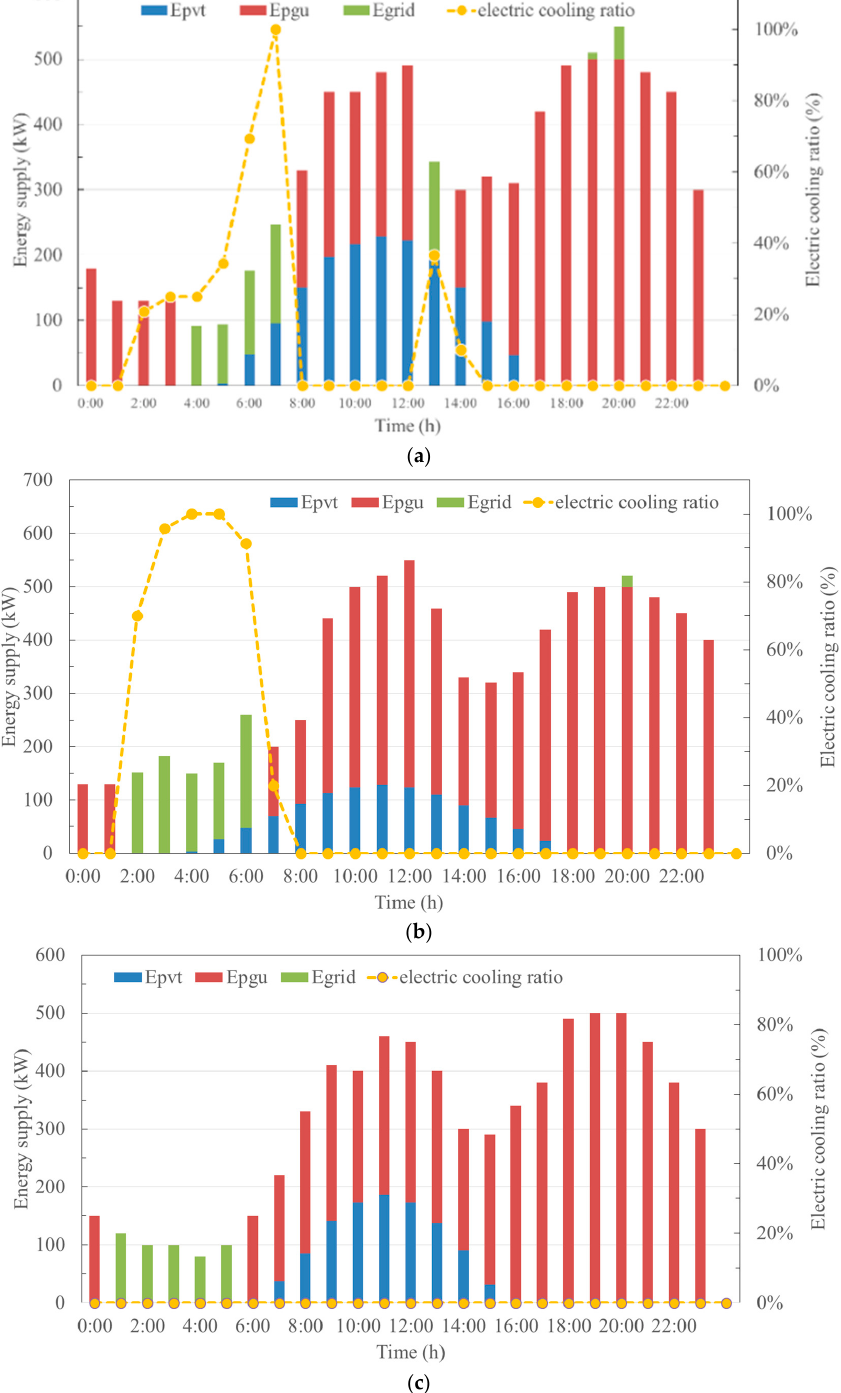
Figure 8. Energy load supply of a residential zone in different season: ( a ) transition season; ( b ) summer; ( c ) winter.